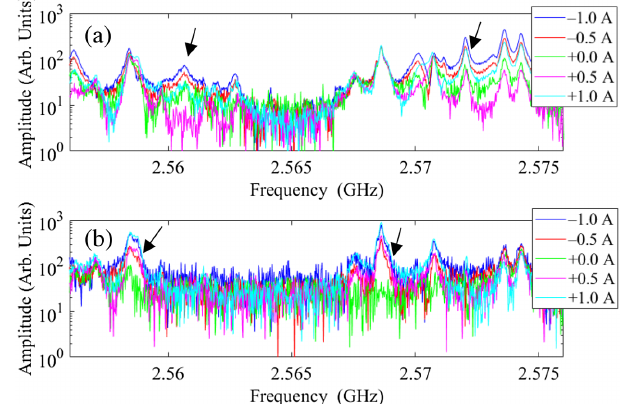
arrows.FIG. 15. HOM signals from the oscilloscope. The curves are different beam trajectories from the same coupler and cavity. (a) These signals are after filtering and include all the modes within the 1.75-GHz bandpass filter. (b) Same signals, but after aligning them in time using the peak at 0